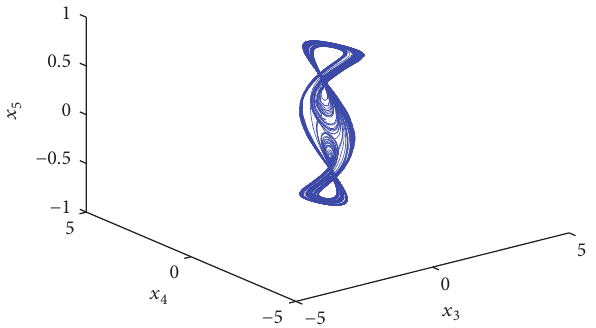
Figure 5: Attractor of the memristor-based five-order chaotic circ- uit